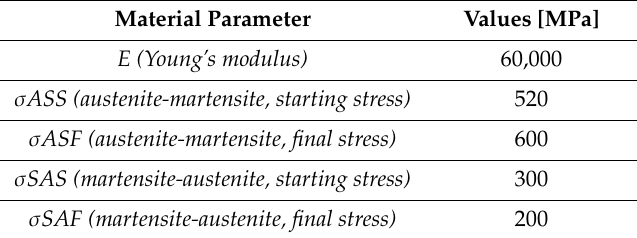
Table 1. Material parameters adopted in the finite element model.